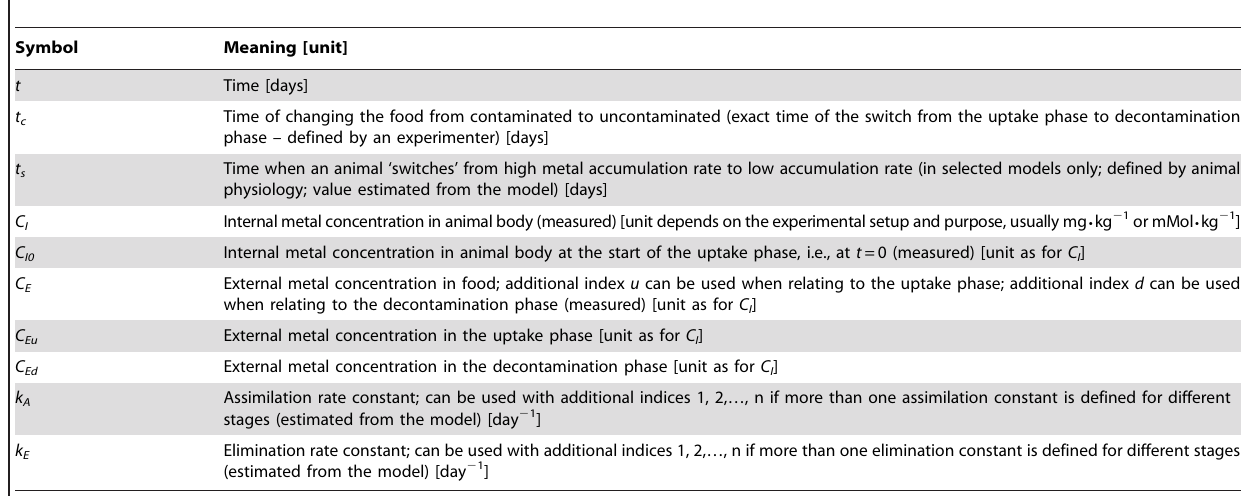
Table 1. Symbols used in the article and the units of model parameters.